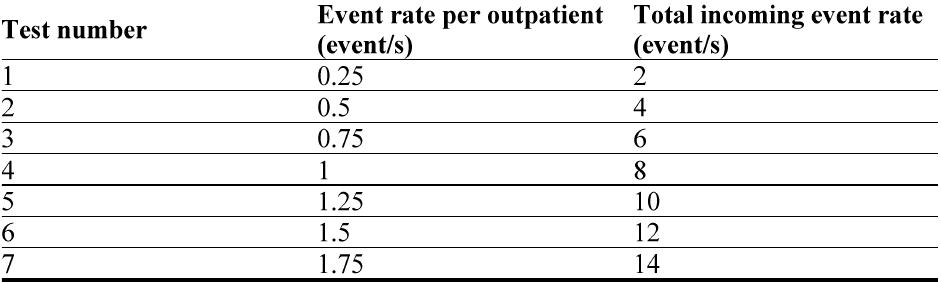
Table 4. Incoming event rate generated for each of the five test series in the second battery of